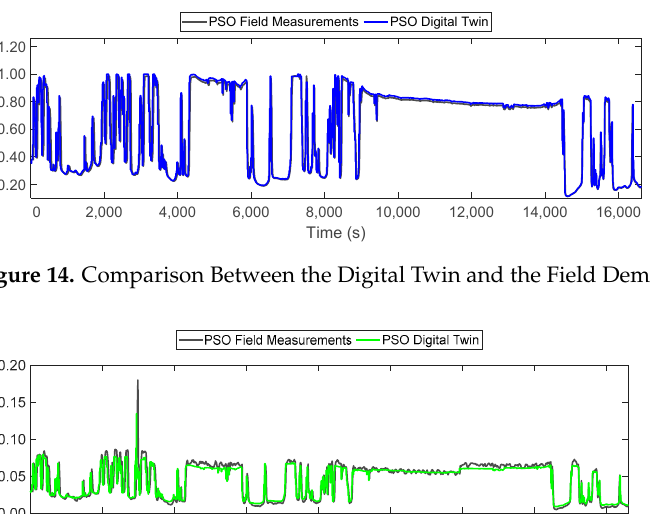
Figure 15. Comparison Between the Digital Twin and the Field Demonstration Reactive Powers.